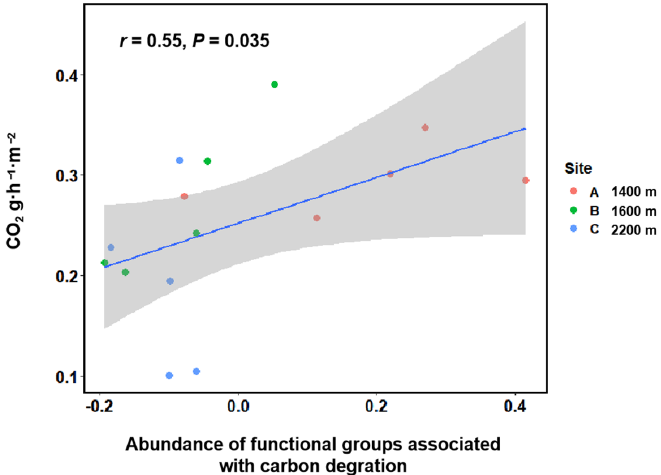
Figure 7. Correlation between soil CO 2 effluxes and abundances of functional groups associated with carbon degradation.